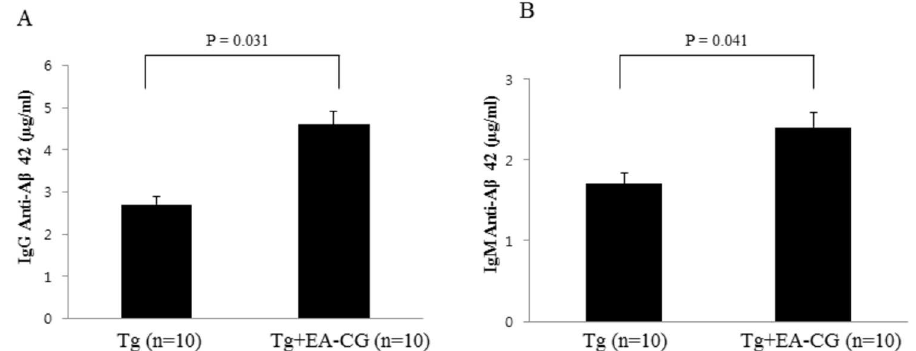
Fig 2. Effect of Centipedegrass (CG) extract on humoral immune response in APP/PS1 transgenic (Tg) mice. The CG ethylacetate (EA-CG) fraction containsfive flavoglycosides, includingMaysin and other phytochemicals, as describedin a previous study [20]. Mouse sera were isolatedfrom the EA-CG-treated and control Tg animal subjects(Mo/Hu APPswe PS1dE9) after feedingwith admixturein diet food for 6 months (n = 10 mice per each group; all male and 10 weeks old mice). (A, B) To measurethe beta amyloid dependent antibody response, using a sandwich ELISA, quantitationwas performed utilize the A β 1–42synthetic peptide as the coating antigenand HRP-conjugated secondary IgG or IgM as a secondary antibody. Immunoglobulin IgG (A) and Immunoglobulin IgM (B), markers of an immune responseagainstthe EA-CG extract, were measuredby ELISA, which was describedin detail in the Materials and Methods. The values were presented as the means ± S.E.M. * p < 0.05 means statisticallysignificant.